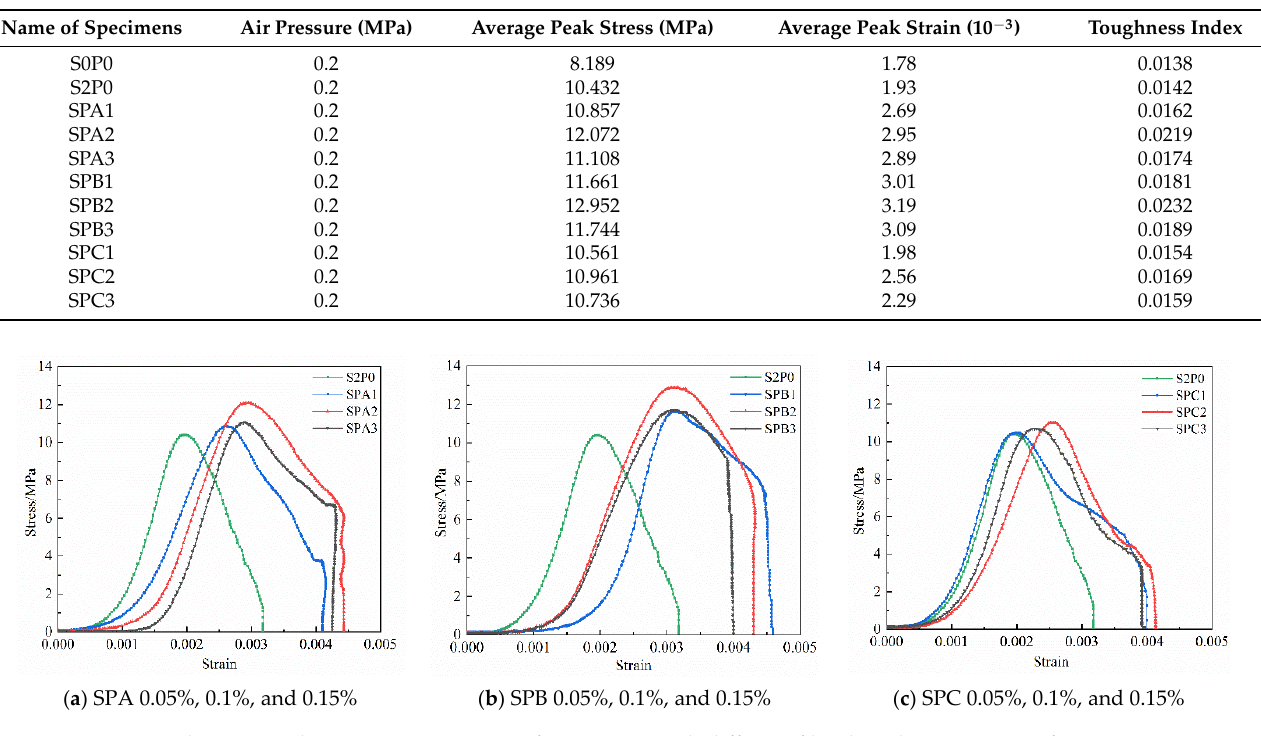
Figure 6. Splitting tensile stress–strain curves of specimens with different fiber lengths at 0.2 MPa of air pressure.